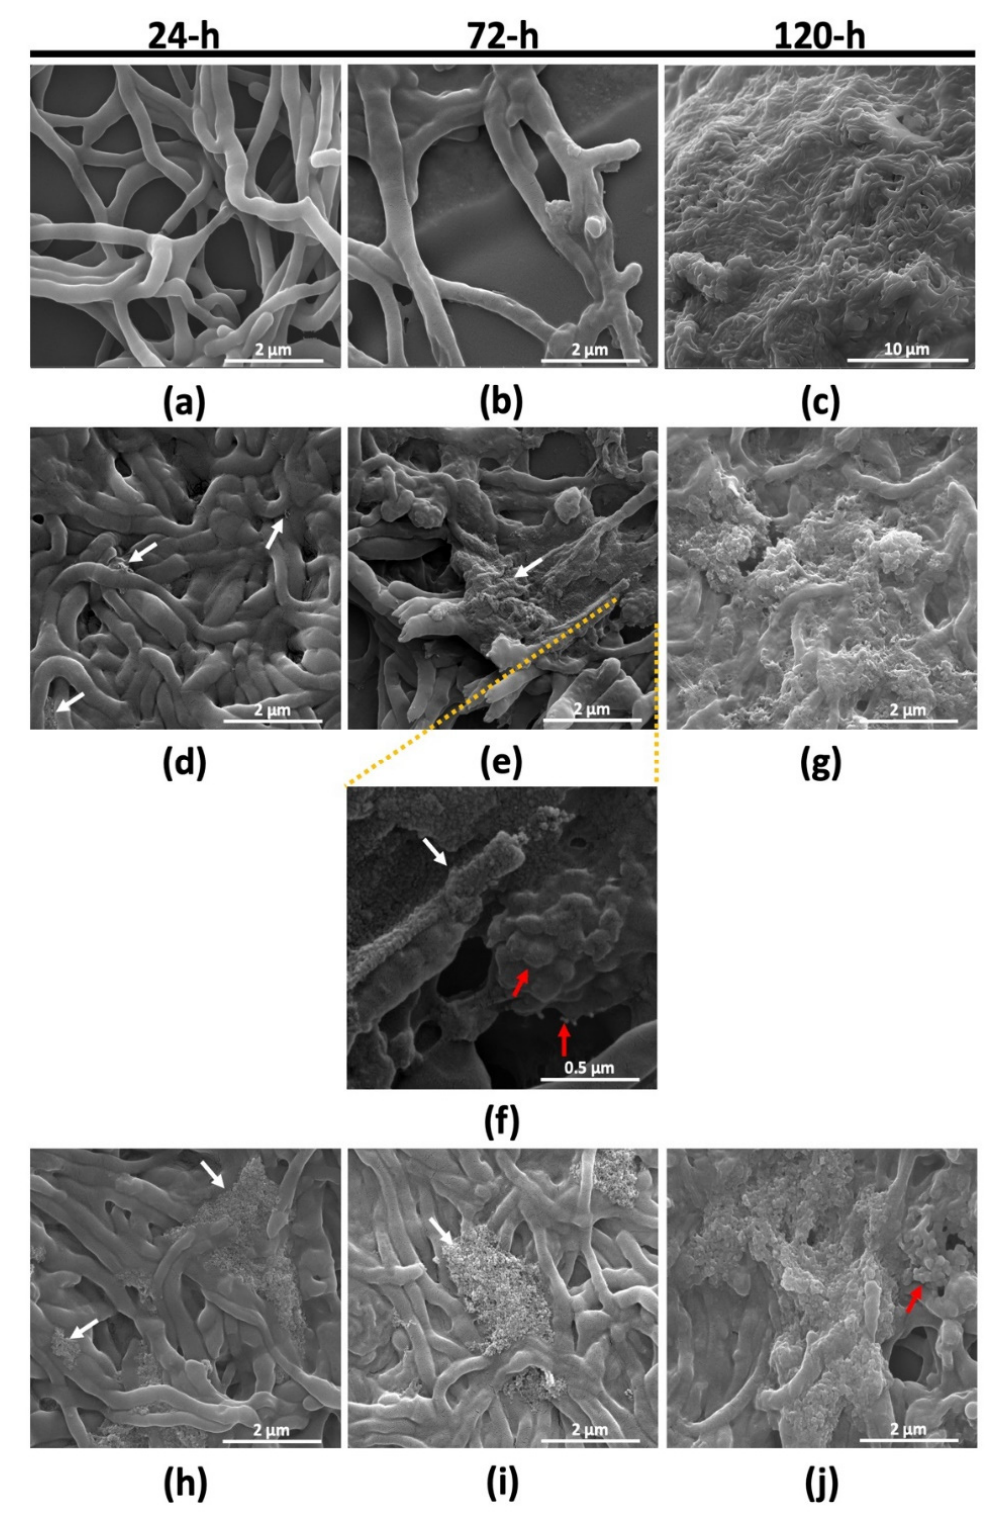
Figure 5. SEM micrographs depicting Micromonospora unchallenged cells ( a – c ) and those grown in the presence of either 100 ( d – g ) or 250 μ M TeO 32 − ( h – j ) over time (24, 72, and 120-h). White arrows highlight oxyanion biosorption on the bacterial surface, while the appearance of membrane vesicle-like structures is indicated with red arrows.